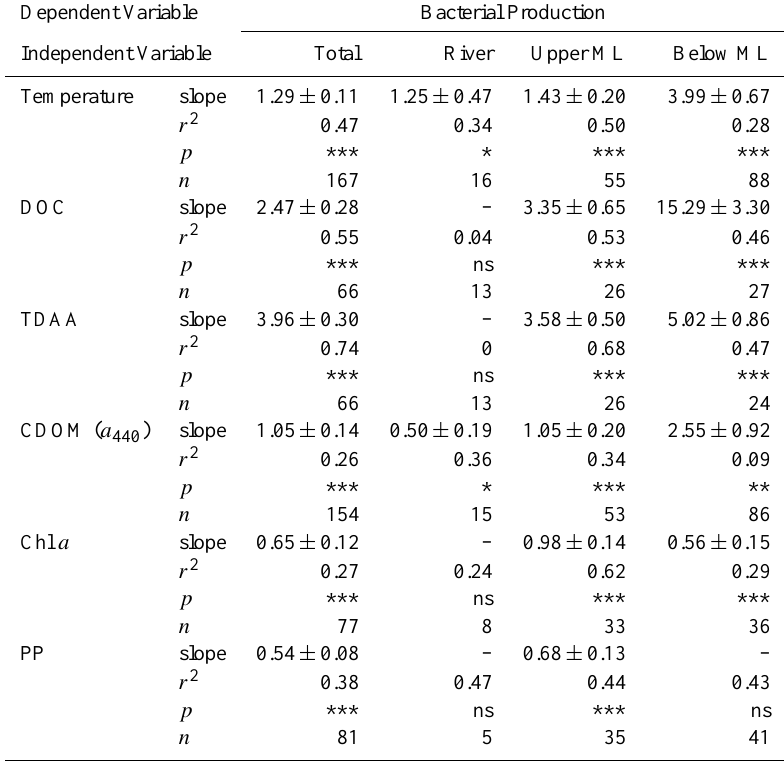
Table 3. Results of regression analyses between temperature, DOC, TDAA, CDOM, chlorophyll a concentration and primary production and bacterial production, all in log 10 . For the analysis, either all data or separated into the different water masses are considered.